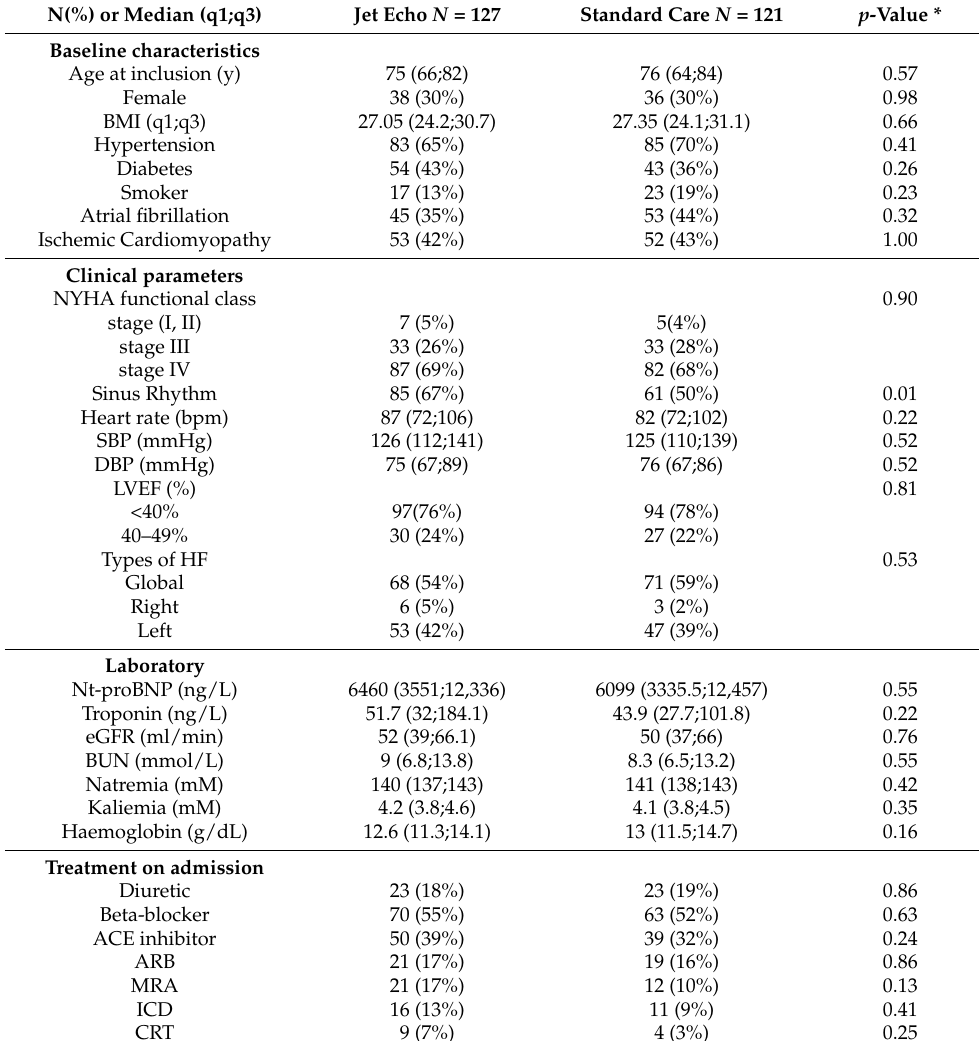
Table 1. Patient characteristics and HF treatments at